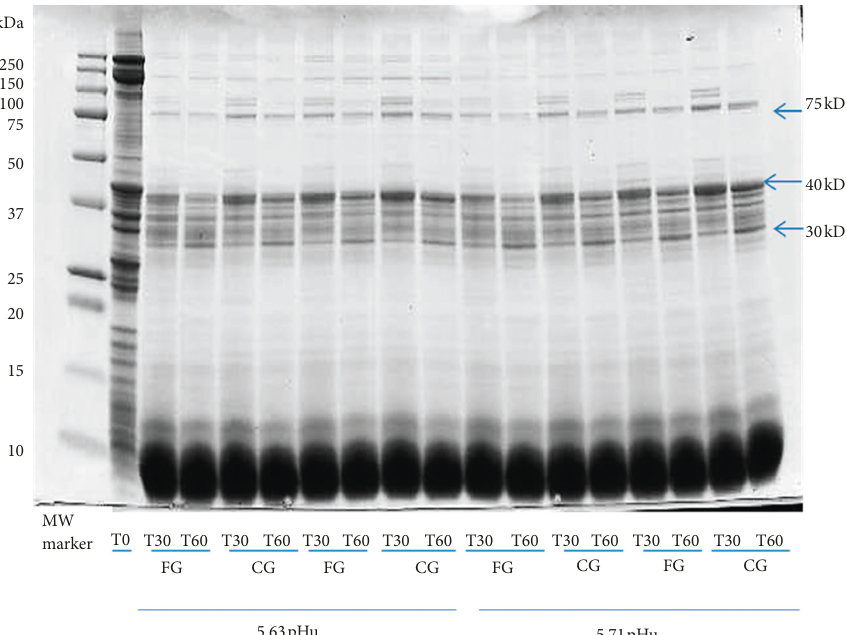
Figure 7: Experiment 2: SDS PAGE showing the effect of mincing/particle size on the digestibility of protein in cooked M. longissimus dorsi from bull beef. Results at T0, T30, and T60 of gastric phase for the two low pHu animals in this experiment are presented as examples. FG � finely ground; CG � coarsely